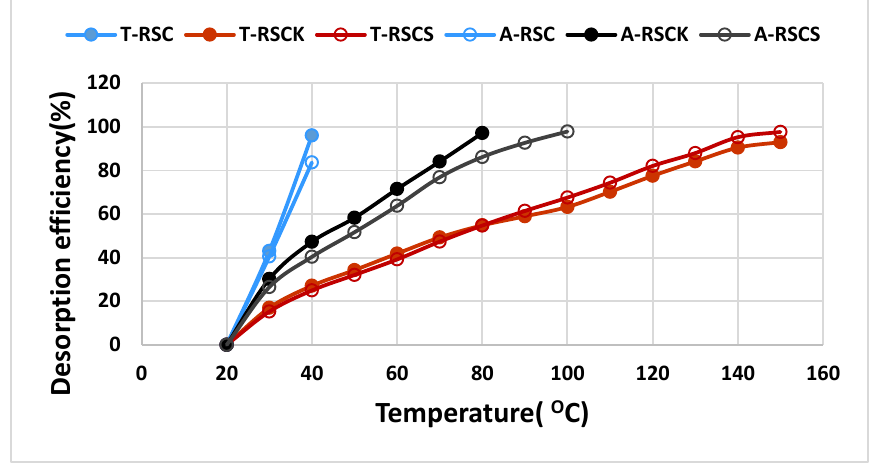
Figure 5. Efficiency of toluene and acetone desorption (T-RSC, T-RSC K , T-RSC S and A-RSC, A-RSC K , A-RSC S ) from nonactivated (RSC) and activated (RSC K , RSC S ) rapeseed cake